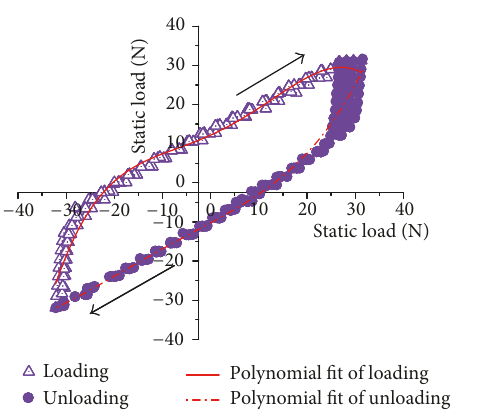
Figure 6: Deflection of protuberant foil journal bearing with static load.